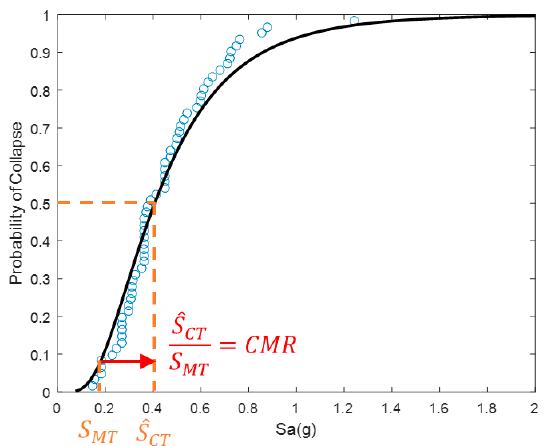
Figure 7. Example of seismic fragility curve.